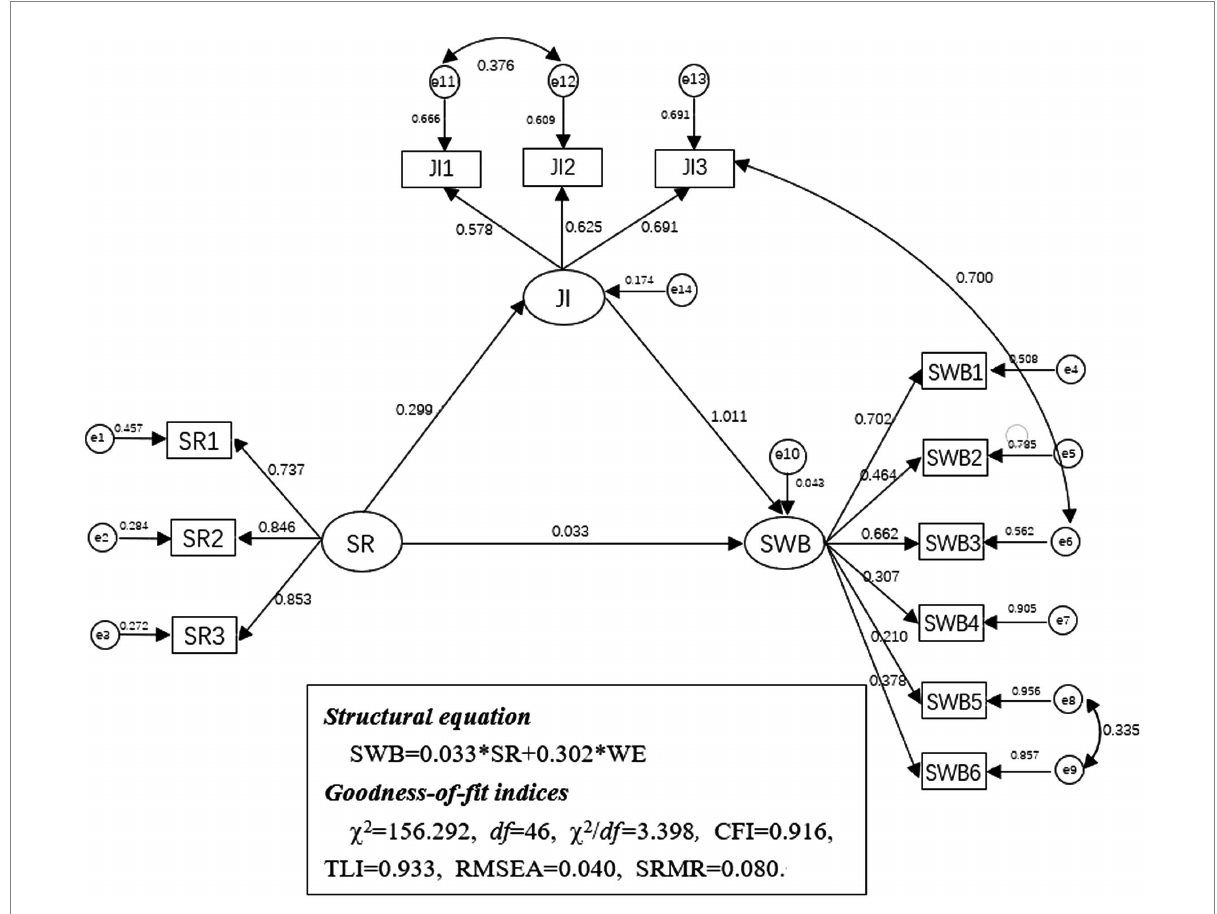
FIGURE 3 Mediation model. SR, Social responsibility; JI, Job involvement; SWB, Subjective